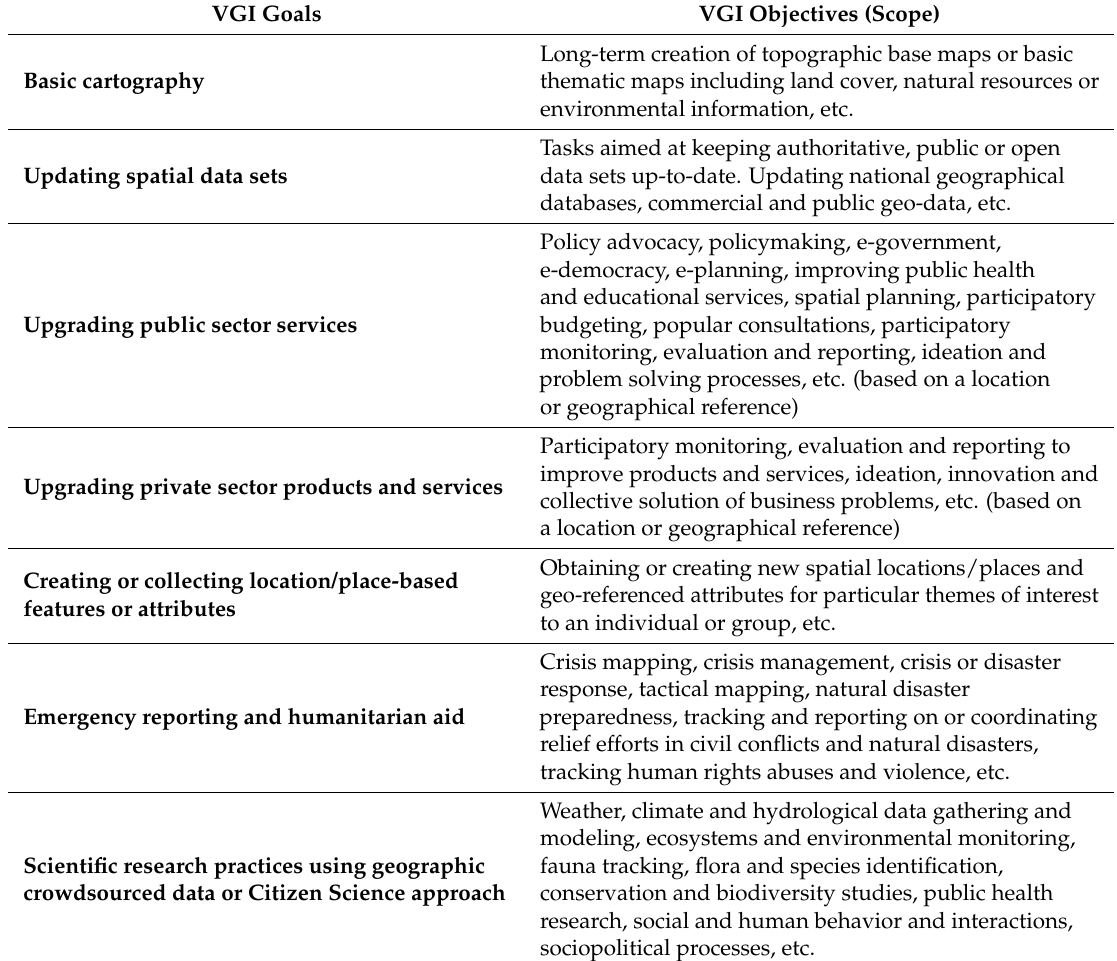
Table 1. Examples of VGI General Project Goals and Related